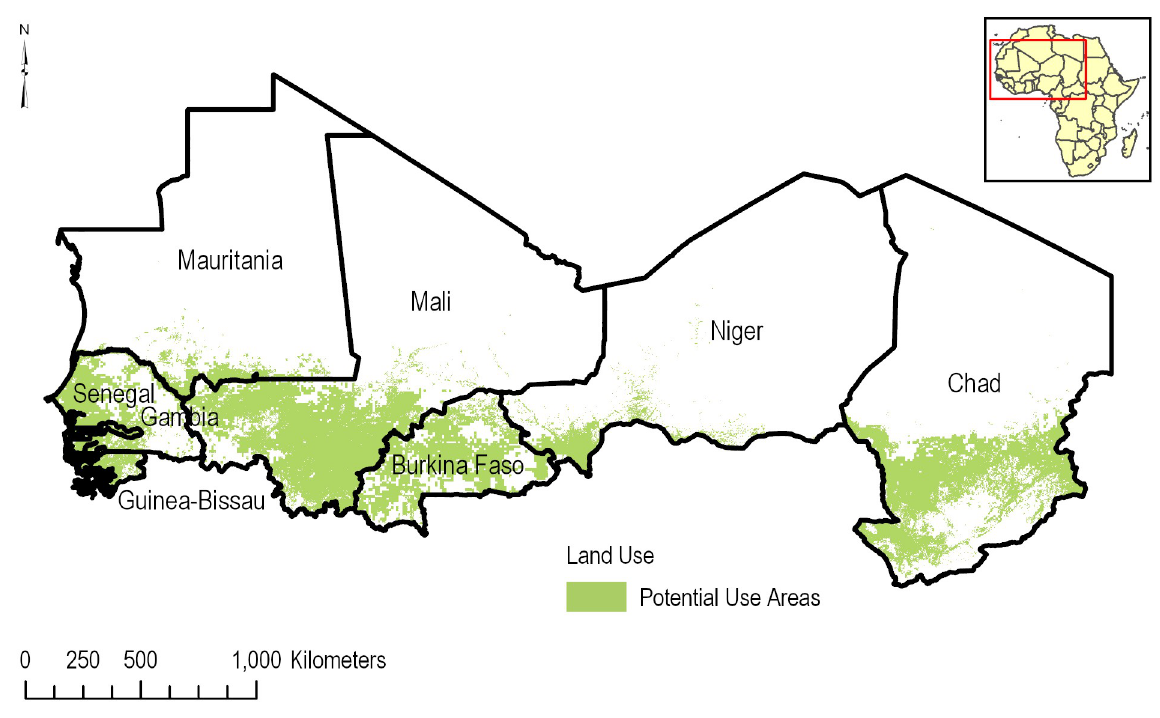
Fig 9. Potential Use Area (PUA) in the CILSS. The PUA consists of the combined corn and cotton production area clipped to the agricultural land uses. https://doi.org/10.1371/journal.pone.0230990.g009 recommended by the ARP for rivers and 61 m (200ft) for lakes, due to data resolution con- cerns, a buffer distance 200m (656 ft) was used to calculate the areas. If a buffer distance of 20 m is applied, no PUA on corn and cotton are adjacent to surface waters in the CILSS region. Table 1. Total crop area (ha) in the potential use area, overlapping vulnerable soils, within proximity of surface water or overlapping shallow groundwater within the CILSS region analyzed. Country Potential use area Vulnerable soils Surface water a assessment Groundwater b assessment Corn (ha)